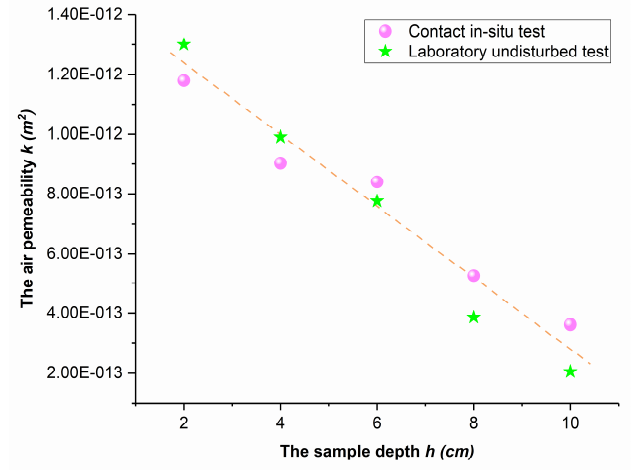
Figure 8. The air permeability values of the in situ contact samples and indoor undisturbed samples.